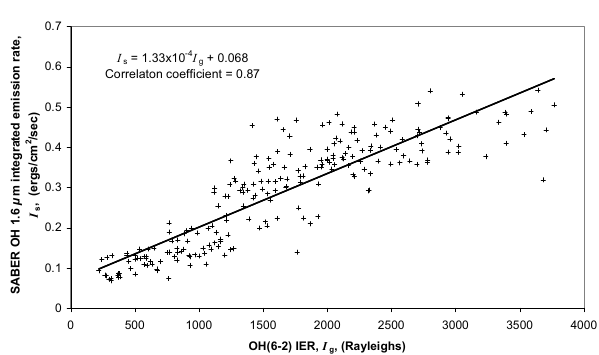
Fig. 5. Scatter plot of integrated emission rates (IER) measured by SABER at Longyearbyen (78 ± 5 ◦ N, 16 ± 10 ◦ E) together with OH(6-2) IER measured by the Ebert-Fastie ground-based spectrom- eter during the period when the two sets of measurements overlap (16 January 2004–19 February 2004). The time window for coinci- dence of the two sets of data is ± 60min.